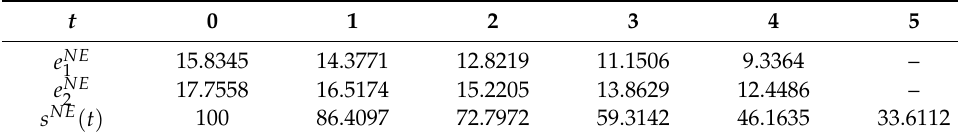
Table 3. NE strategies and NE state trajectory for a unicriterion game.